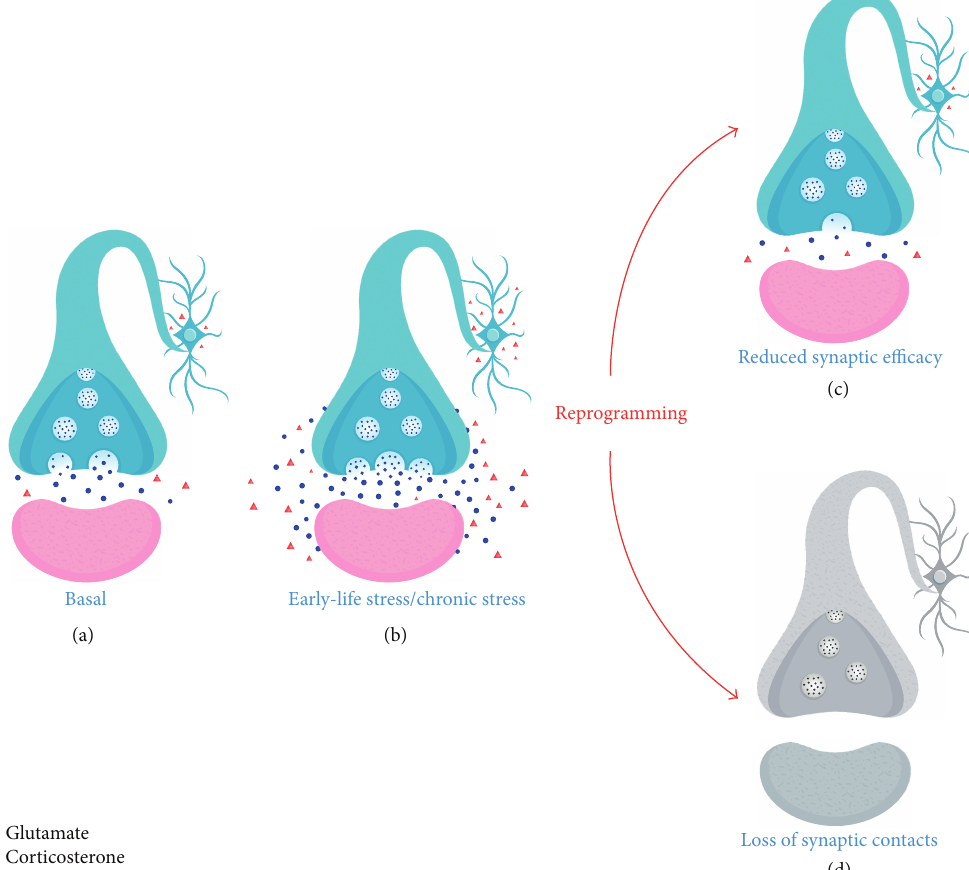
Figure 2: Long-term neuroplastic alterations induced by early-life stress and chronic stress. (a) Basal condition: presynaptic neuron (light blue), postsynaptic neuron (pink). (b) Repeated episodes of stress in early life or in adulthood induce an increase in glucocorticoids associated withatransientincreaseinglutamatereleasebothinthesynapticcleftandintheextrasynapticspace.Increaseinglutamatereleasemayactivate reprogramming mechanisms that lead to either reduced synaptic efficacy (c) or loss of synaptic contacts